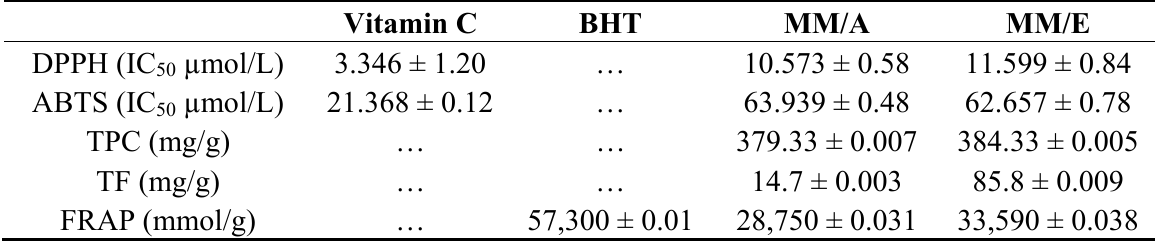
Table 1. DPPH, ABTS, FRAP radical scavenging activities with total phenolic and total flavonoids contents of MM